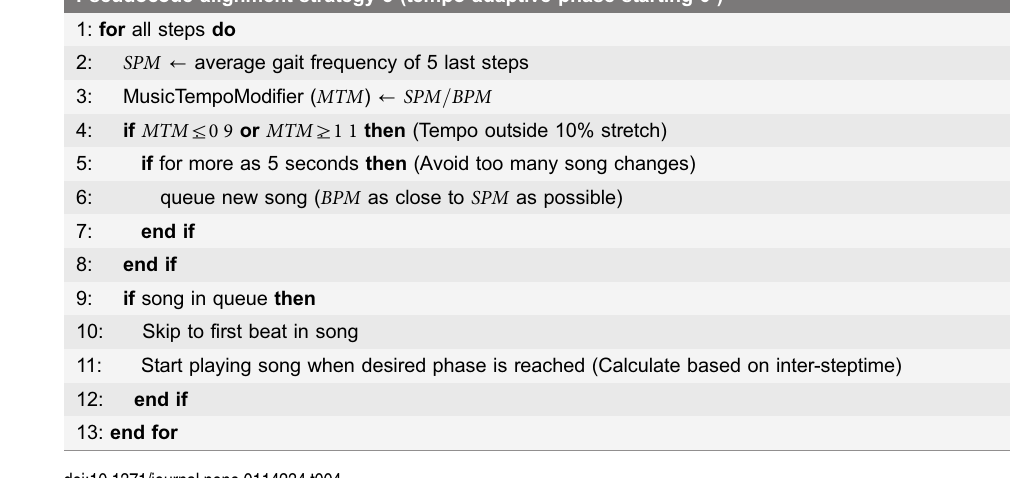
Table 4. Algorithm